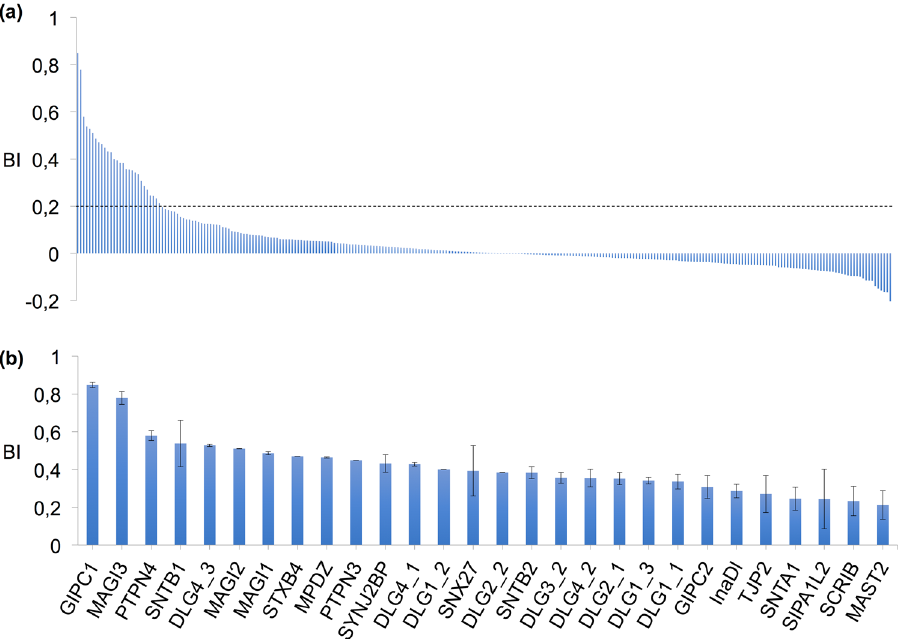
Figure 5. PDZome binding of HBc investigated by in vitro holdup protein-peptide binding assays. ( a ) PDZome-binding profile of PBM-HBc. PDZ domains are ranked on the basis of their BIs for the PBM-HBc peptide. A dashed line indicates the cut-off for a significant PDZ–PBM interaction (BI > 0.2). ( b ) Zoom-in on the 28 HBc binders with a BI > 0.2. The data and error bars are representative of two independent